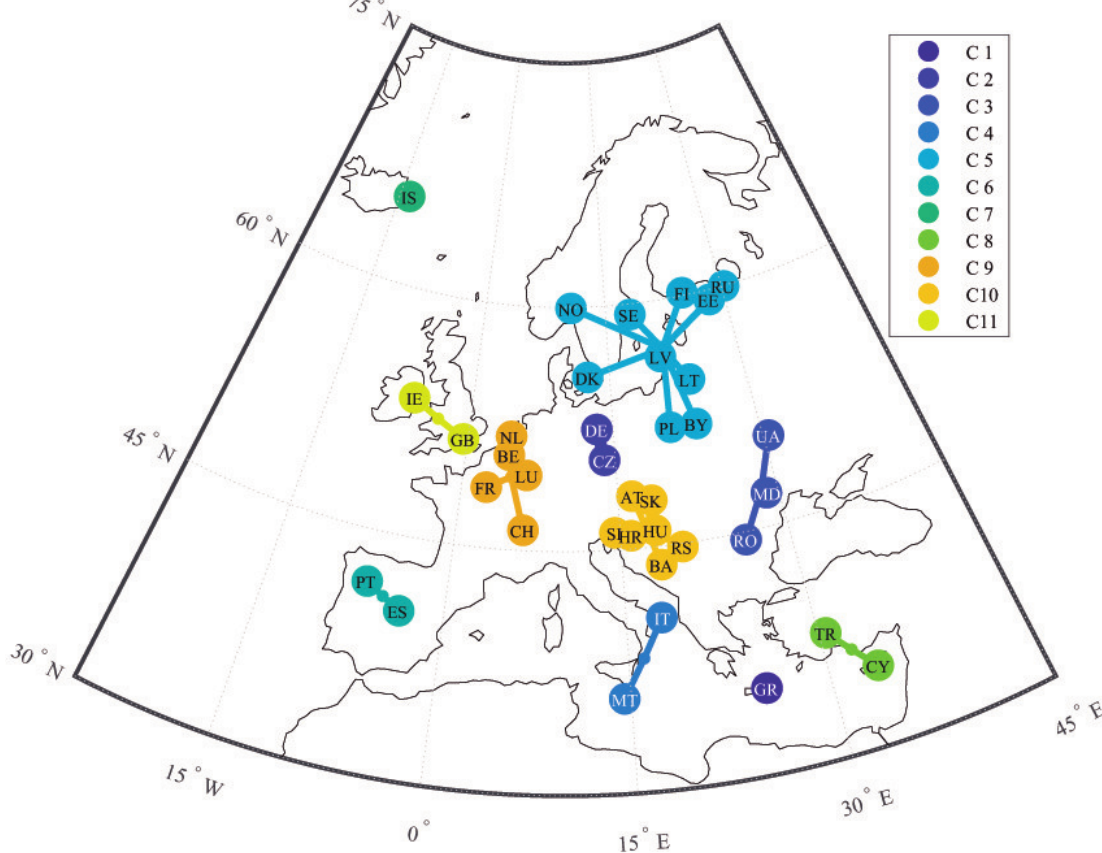
Figure 8. Location of the reference weather stations. The coloured clusters correspond to those formed using the dendrogram of Figure 7a, based on the maximum